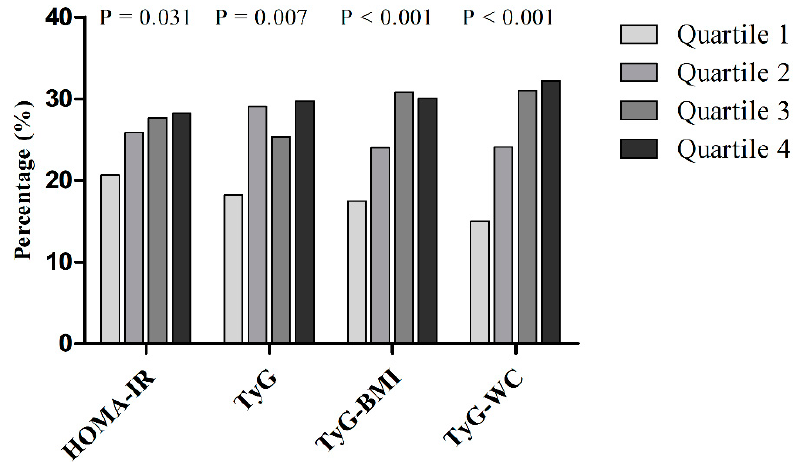
Figure 2. Proportion of progressors by their CAC scores according to the quartiles of homeostasis model assessment of insulin resistance (HOMA-IR), triglyceride glucose (TyG), TyG-BMI (body mass index), and TyG-WC (waist circumference) in the final cohort including non-progressors and progressors ( n = 1145). The proportion of progressors was compared using the chi-squared test.